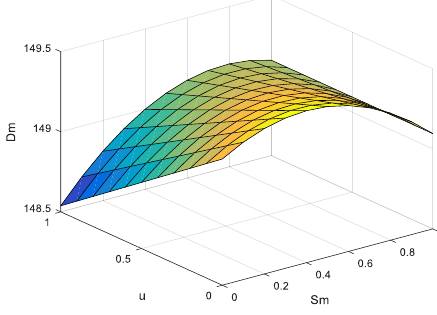
Figure 6. Effect of s m and µ on D m .